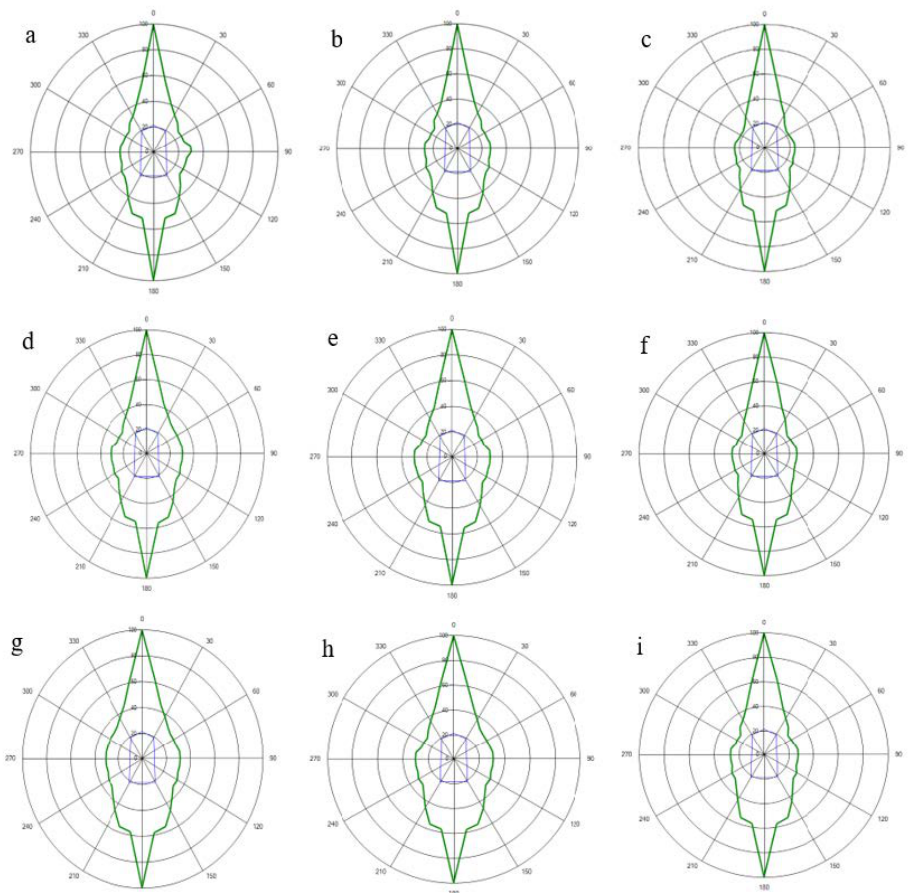
Figure 16. Capability plots for anchor-based positioning.